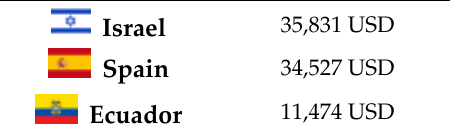
Table 4. GDP per capita.